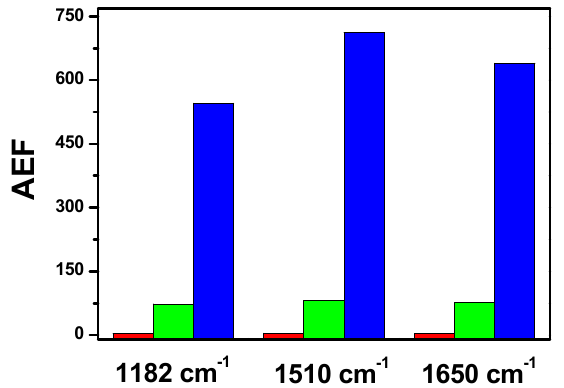
Figure 9. Bar plot of analytical enhancement factor (AEF) of MIF-H (red bar), NIF@GO-AgNPs (green bar), and MIF@GO-AgNPs (blue bar) at different Raman modes, 1182, 1510, and 1650 cm − 1 .